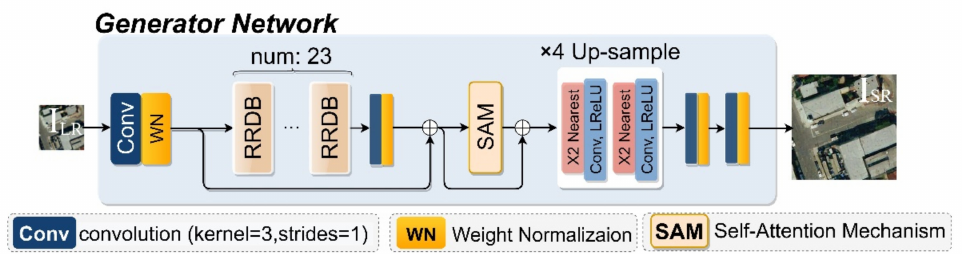
Figure 2. Structure of the generator network of TE-SAGAN.